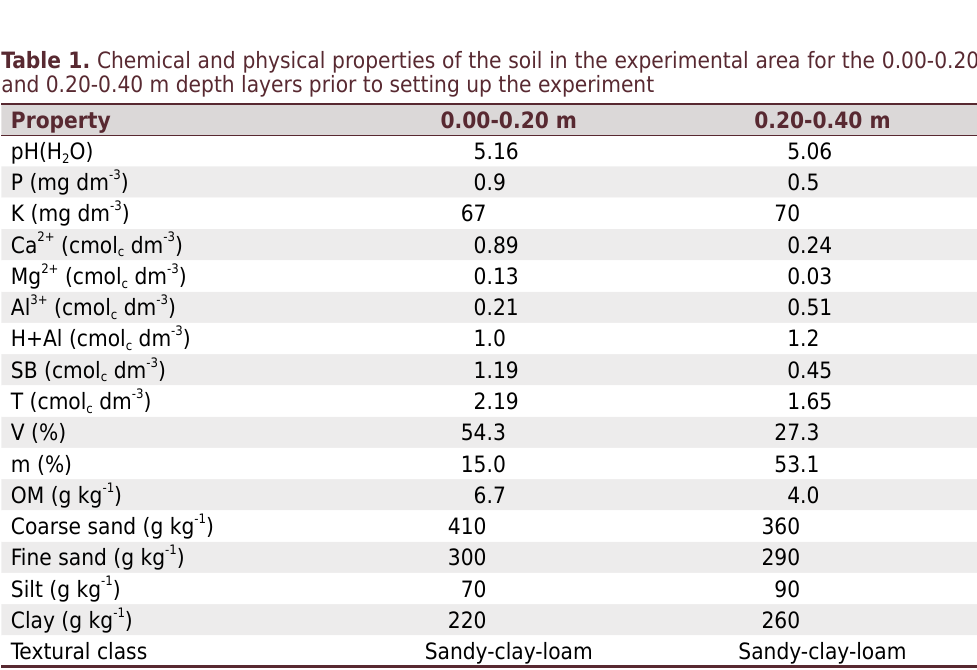
Figure 1. Mean monthly values for rainfall, mean air temperature, and relative humidity from October 2010 to October 2011. Boa Vista, Roraima,